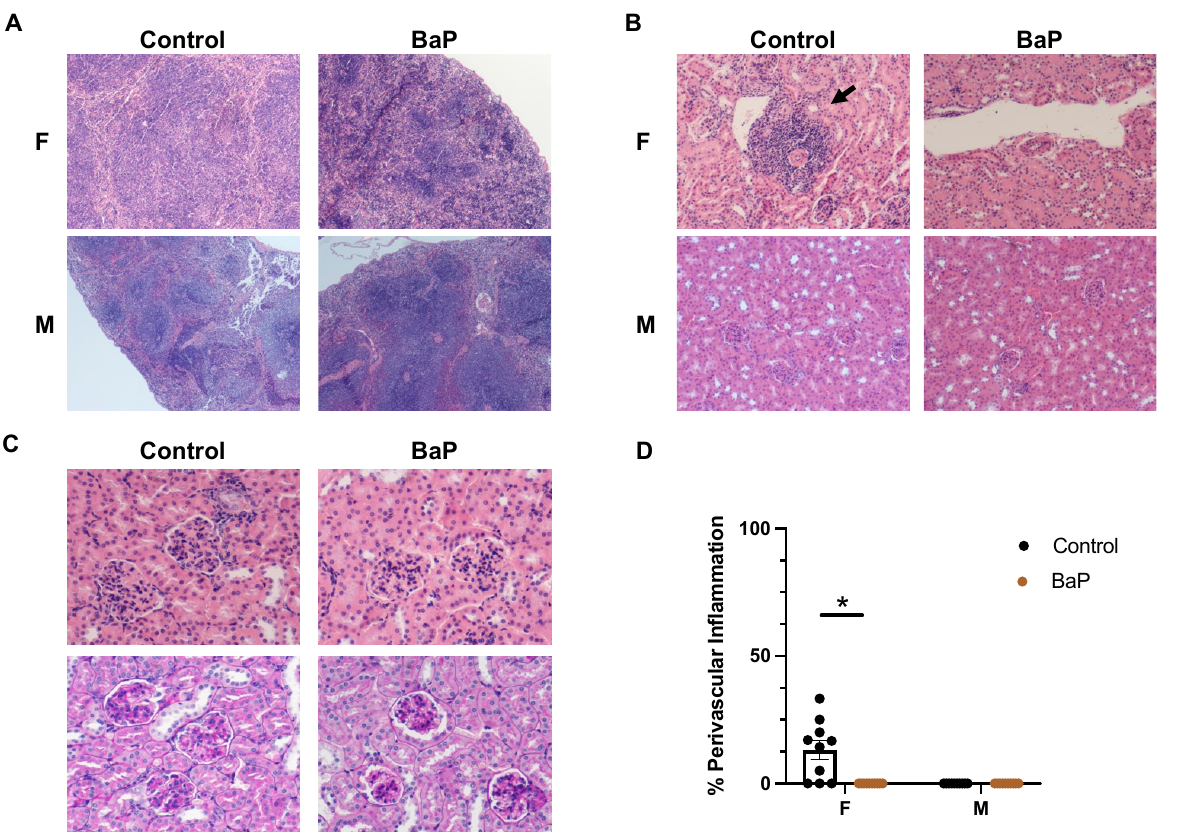
Figure 3. BaP exposure disrupted white pulp in the spleen and reduced inflammation in the kidney of female MRL mice. ( A ) H&E staining of female (F) or male (M) MRL spleen upon vehicle (control) or BaP (BaP) treatment (4×). ( B ) H&E staining of female (F) or male (M) MRL kidney upon vehicle (control) or BaP (BaP) treatment, with the arrow pointing to the site of perivascular inflammation in the cortex (4×). ( C ) H&E (top) and PAS (below) staining of glomeruli in female MRL mice upon vehicle (control) or BaP (BaP) treatment (4×). ( D ) Quantification of arteriolar inflammation in the renal cortex of female (F) or male (M) vehicle (control) or BaP (BaP)-treated kidney. *, p < 0.05, Student’s t -test.